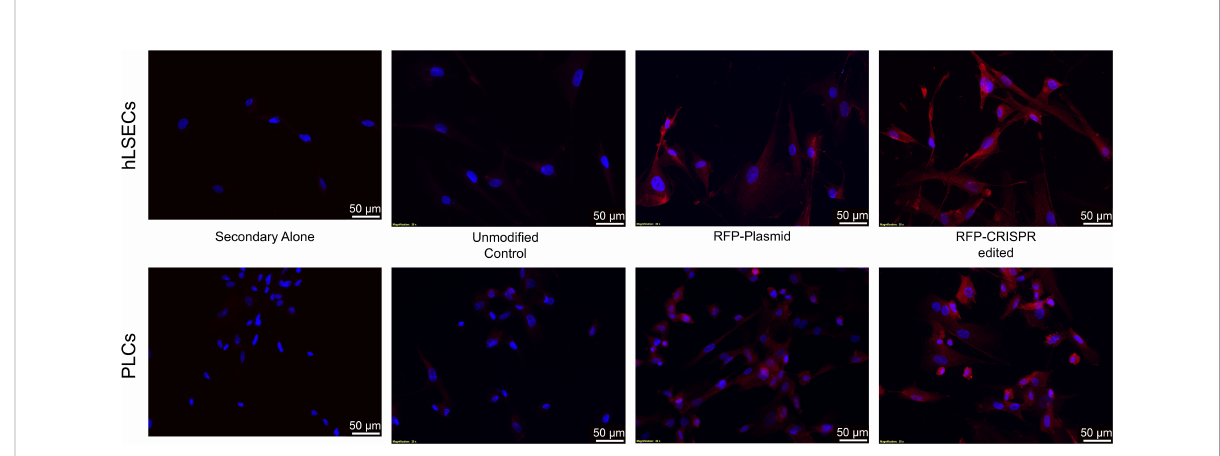
FIGURE 10 Immuno fl uorescence analysis of intracellular RFP protein in unmodi fi ed and gene-modi fi ed PLCs and hLSECs. PLCs (top panel) and hLSECs (bottom panel) in each experimental group were stained with a primary antibody for RFP that was then detected with an AlexaFluor ® 594-conjugated secondary antibody (red) and nuclei were counterstained with DAPI (blue). Controls consisted of slides with unmodi fi ed PLCs and hLSECs stained identically (labeled “ controls ” ) and slides of each cell type stained with secondary antibody alone to establish levels of background fl